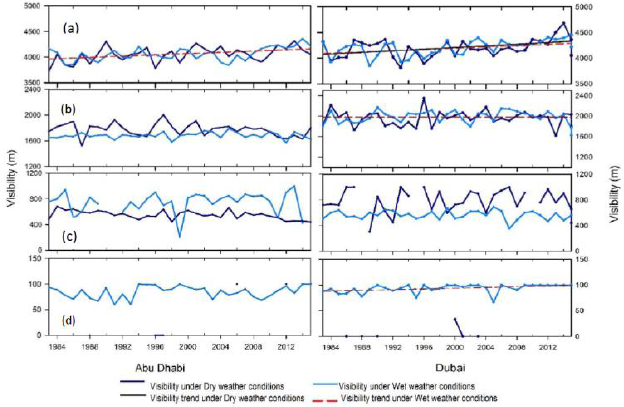
Figure 7. Abu Dhabi and Dubai long-term average visibility values under wet and dry weather conditions for different visibility classes: ( a ) 5.0–2.5 km, ( b ) 2.5–1.0 km, ( c ) 1.0–0.10 km, and ( d ) <0.1 km. Only significant trends are presented.